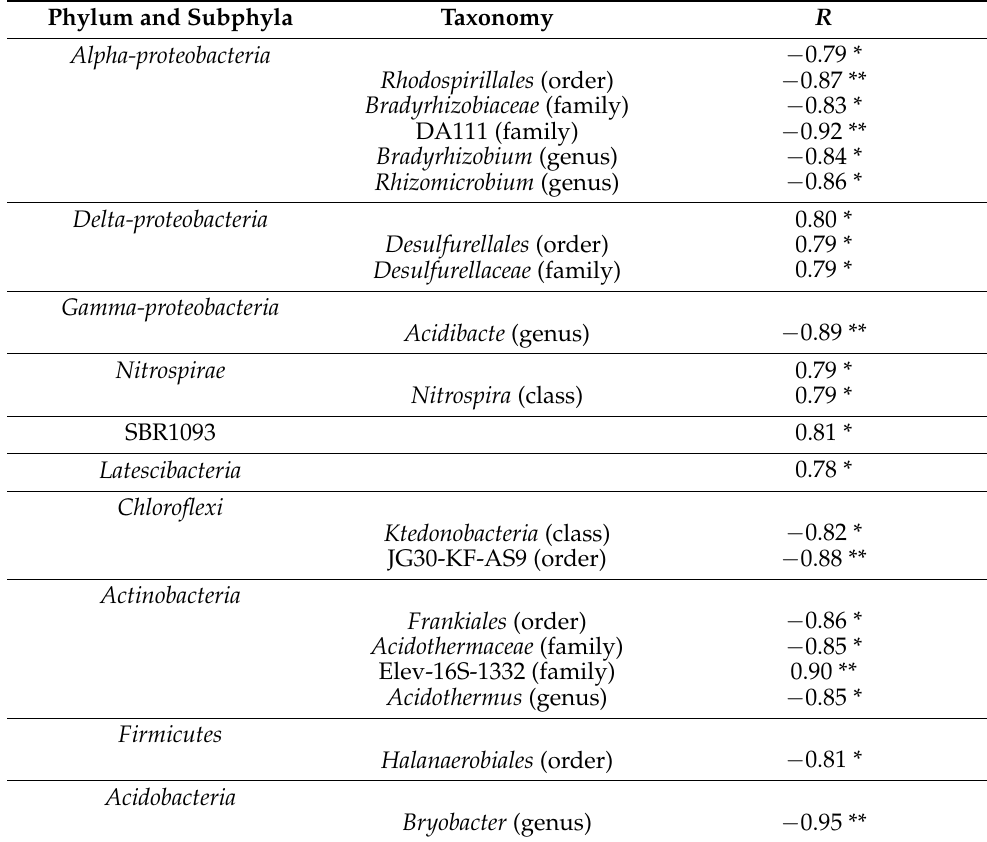
Figure 4. The relative abundance of the top-10 bacterial taxa at the phyla (black), class (blue), order (red), family(green), and genus (yellow) levels for all samples. Table 2. The Pearson’s correlation analysis of bacteria abundance and nitrogen fertilization gradient. * and ** indicate significant correlations at p < 0.05 and p < 0.01,